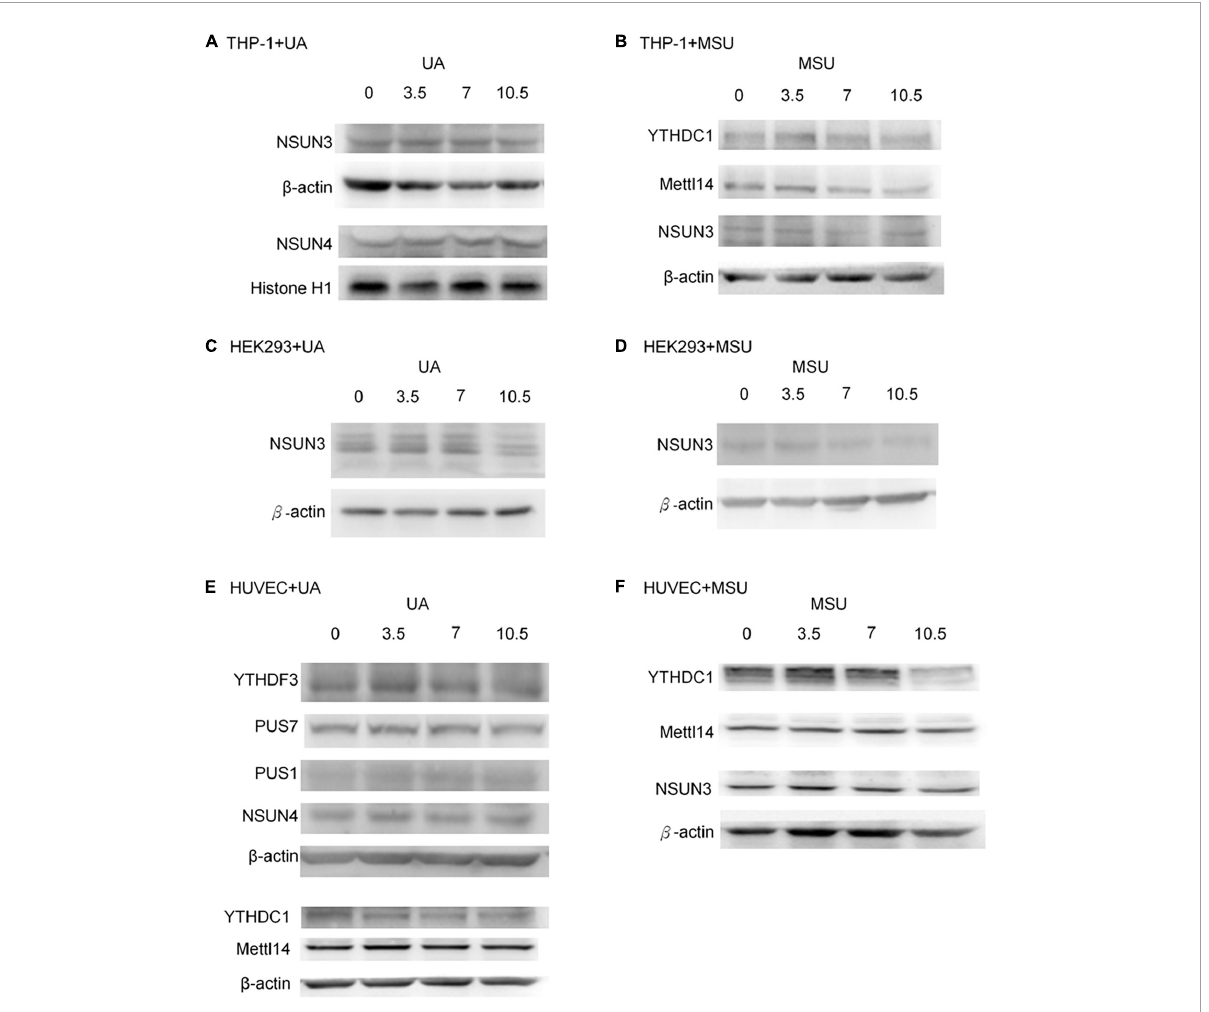
FIGURE2 Protein expressions of RNA modification enzymes were affected in MSU- or UA-treated cell lines. The expressions of RNA modification enzymes that changed with RNA levels were detected through Western blotting. (A) NSUN3 and NSUN4 were detected in UA-treated THP-1 cells. (B) YTHDC1, METTL14, and NSUN3 were detected in MSU-treated THP-1 cells. (C,D) NSUN3 was detected in UA-and MSU-treated HEK293 cells. (E) YTHDF3, PUS7, PUS1, NSUN4, YTHDC1, and METTL14 were detected in UA-treated HUVEC cells. (F) YTHDC1, METTL14, and NSUN3 were detected in MSU-treated HUVEC cells. β -actin and histone H1 served as the internal control. Representative results from three independent experiments are presented.